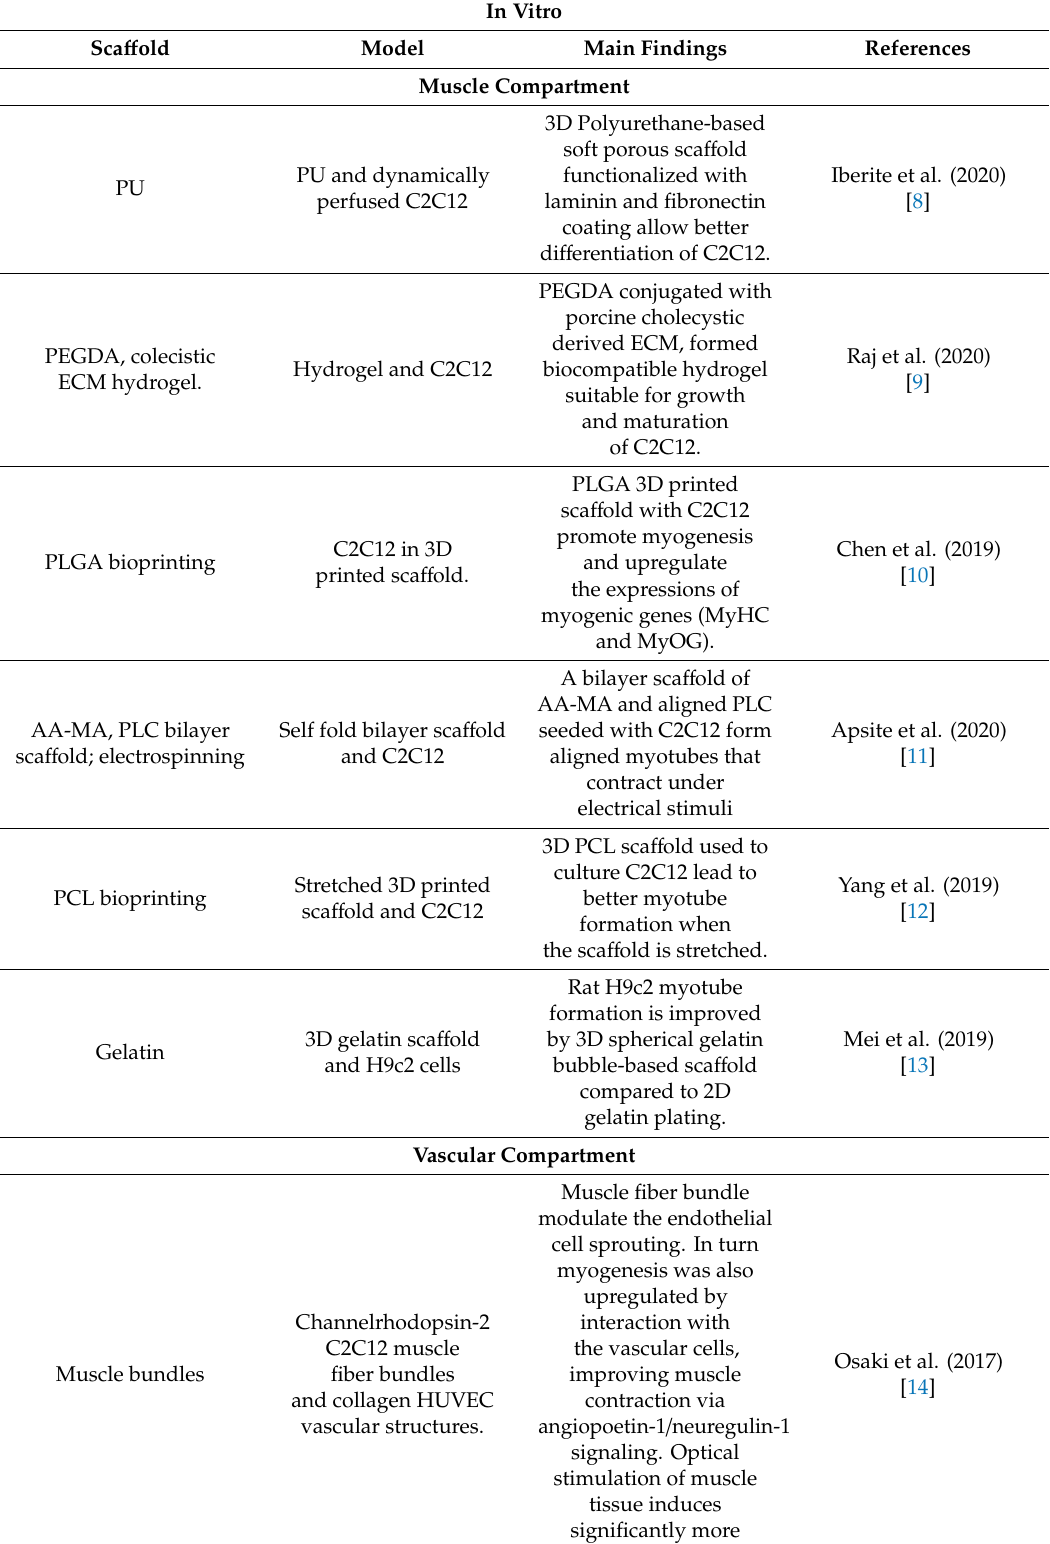
Table 1. In vitro tissue engineering